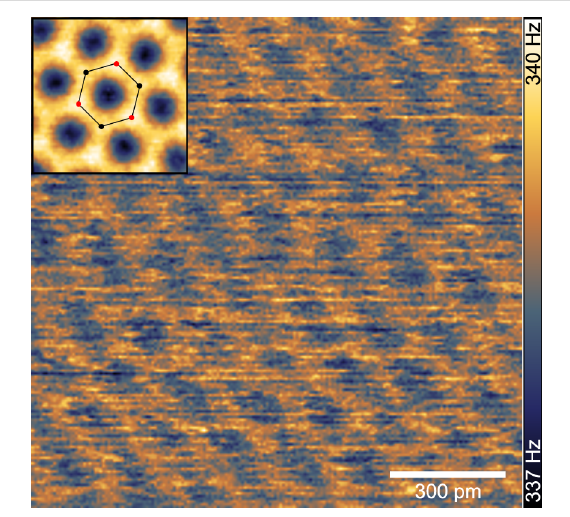
Figure 6: High-resolution detuning image of HOPG in quasi-constant height mode. Inset: 3-fold symmetrised drift-compensated correlation average with overlaid honeycomb structure. A = 220 pm, scan speed 58.6